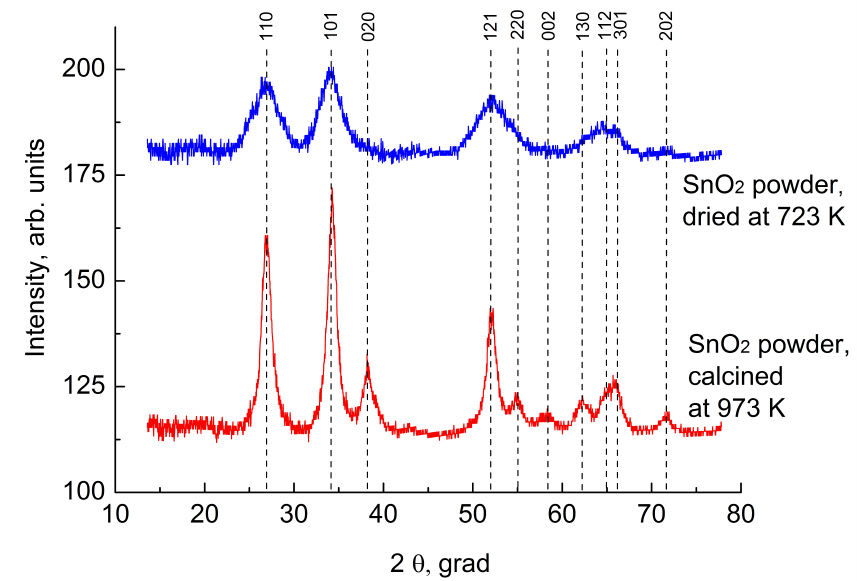
Figure 1. X-ray diffraction picture of the tin dioxide powder after dried at 723 K and calcined at 973 K.